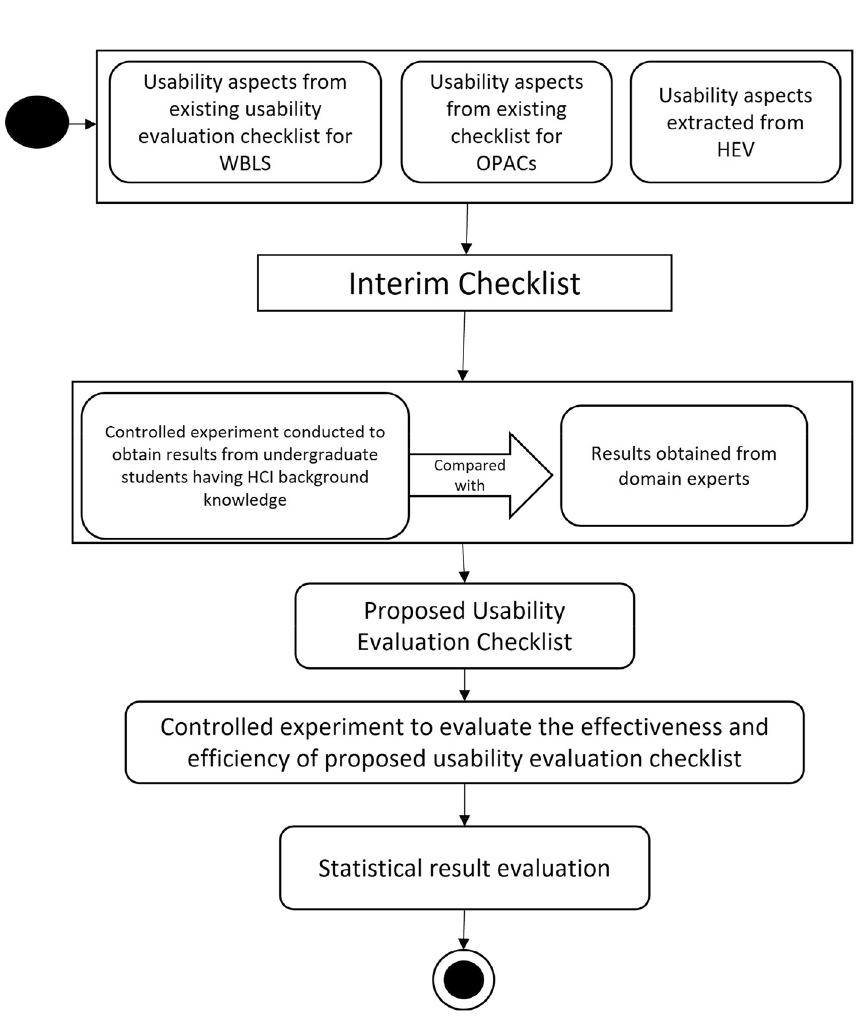
Figure 1. Proposed